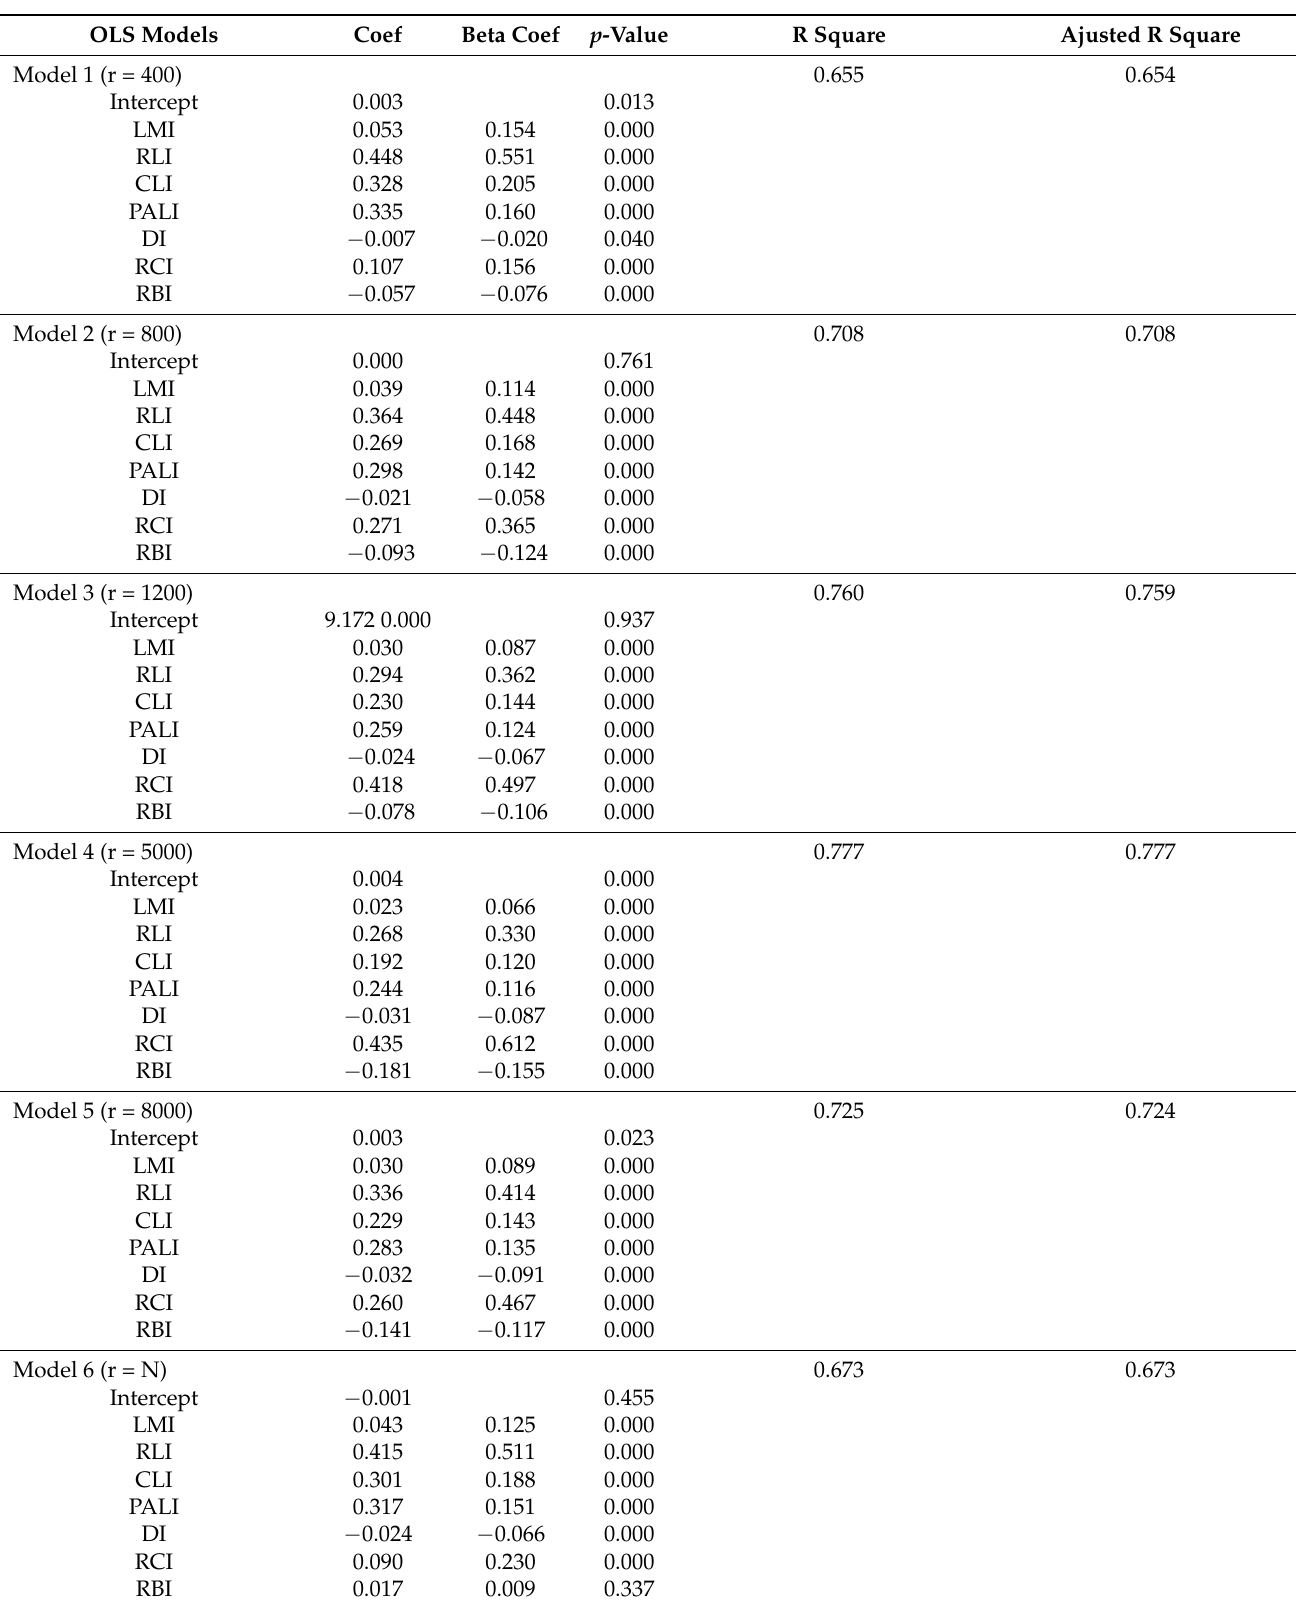
Table A6. The resulting for ols model between UV and built environment variables under different search